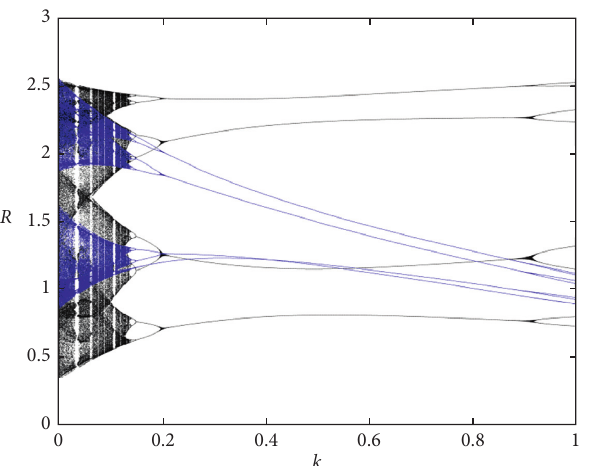
Figure 14: Bifurcation diagram with respect to control factor k